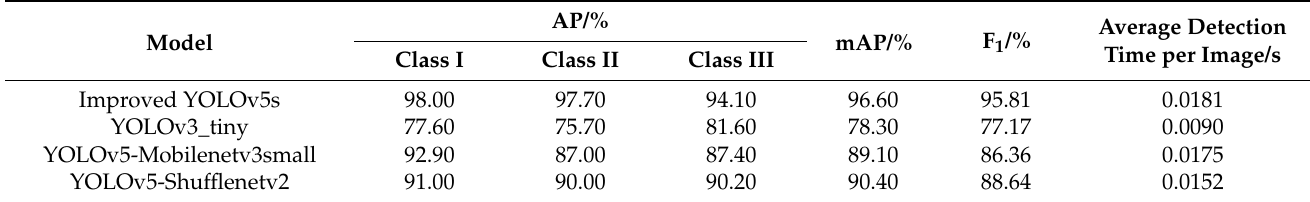
Table 4. Comparison of detection capabilities of different network